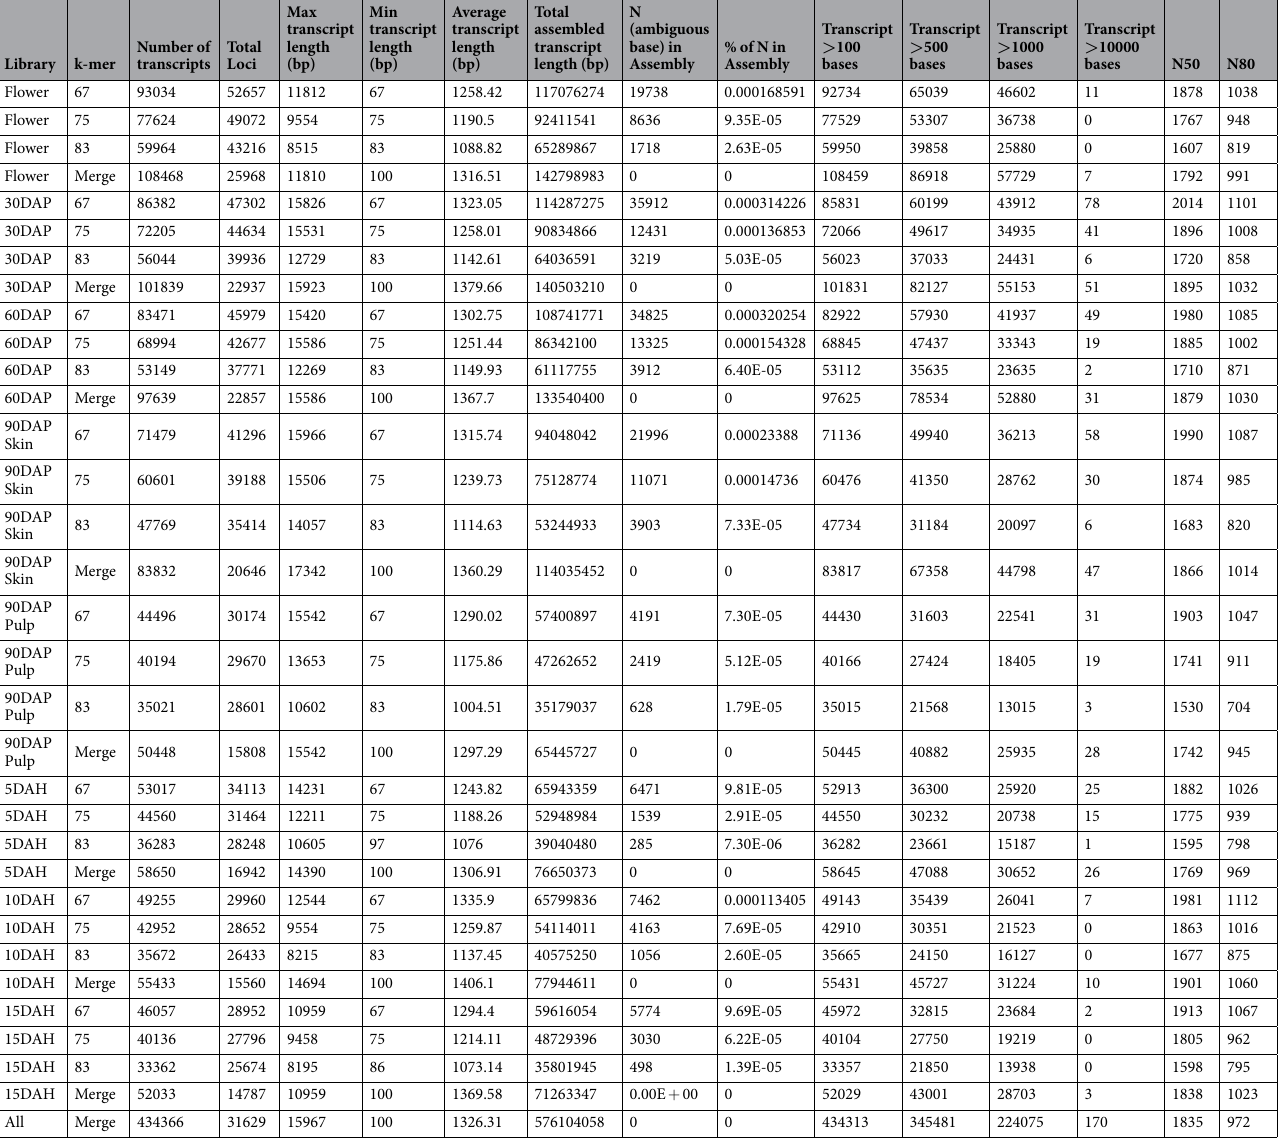
Table 1. Alphonso de novo transcriptome assembly statistics.